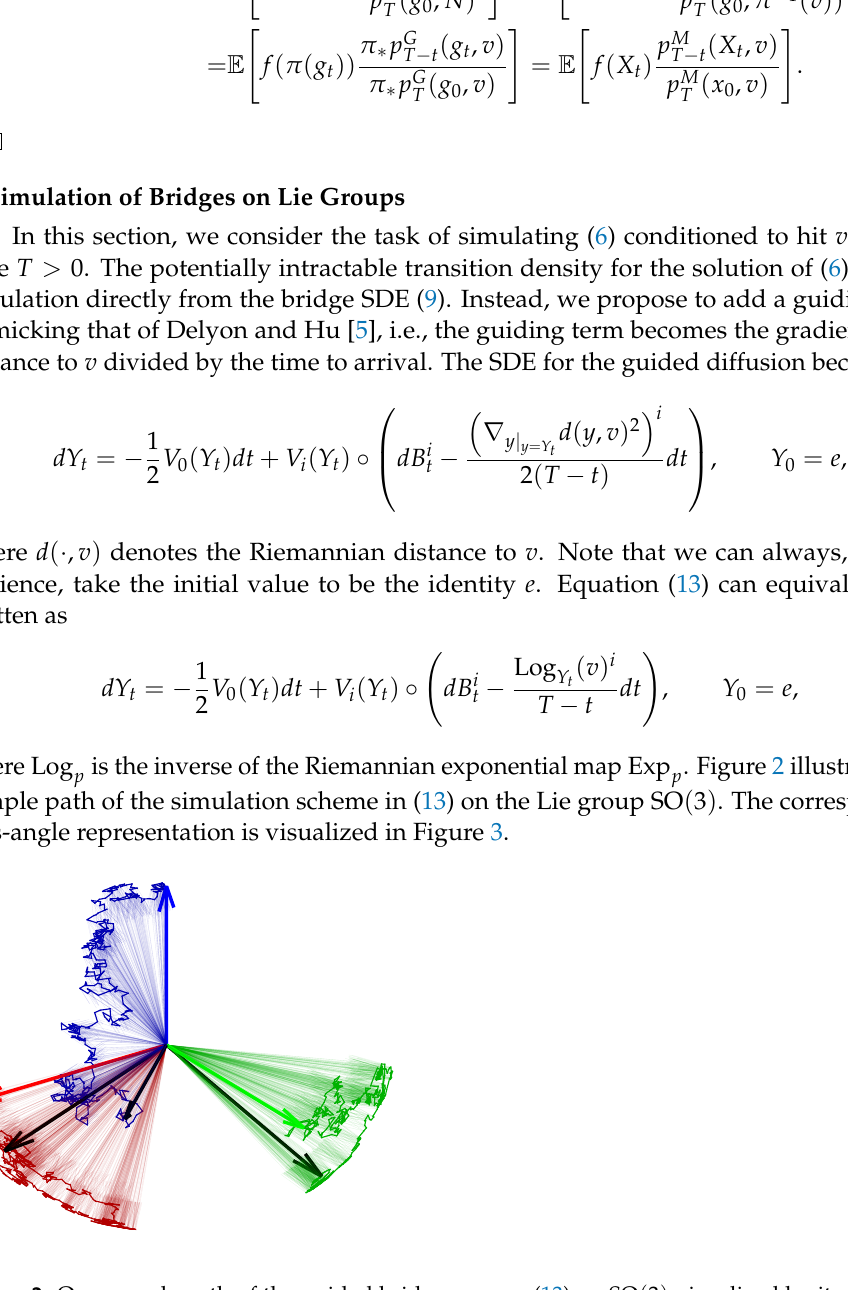
Figure 2. One sample path of the guided bridge process (13) on SO ( 3 ) visualized by its action on the basis vectors (red, blue, green) of R 3 . The bridge is conditioned on the rotation indicated by the black